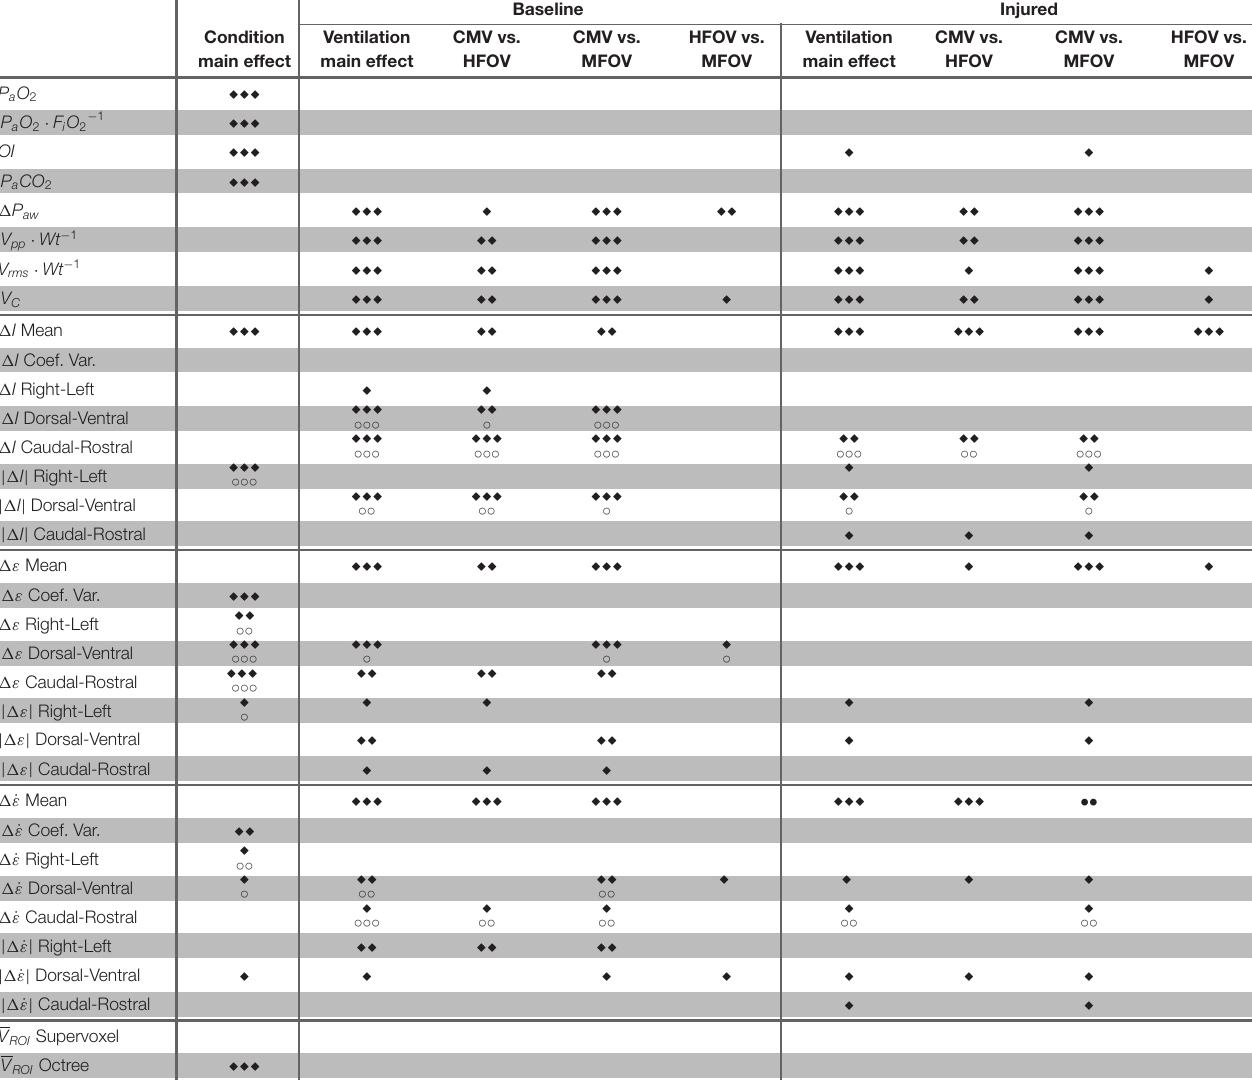
TABLE 2 | Statistically significant effects determined by Kruskal-Wallis rank sum test for main effects of lung condition (i.e., baseline, injured) and ventilation modality (i.e., CMV, HFOV,